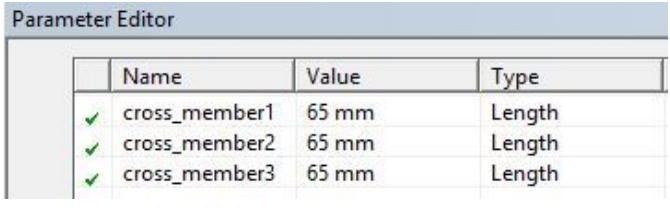
Figure 12. Dimensions of cross members.